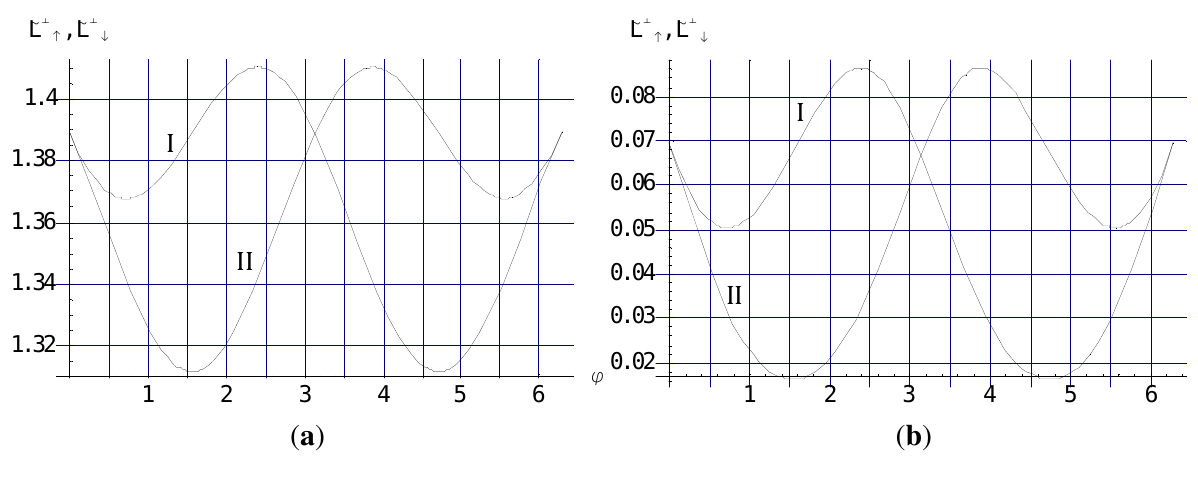
Figure 4. ˜ L ⊥ (curve I) and ˜ L ⊥ (curve II) versus ϕ (in radian). ( a ) for ka = 0 . 01 , and ( b ) for ↓ ↑ ka = 0 . 2 according to Equations (40) and